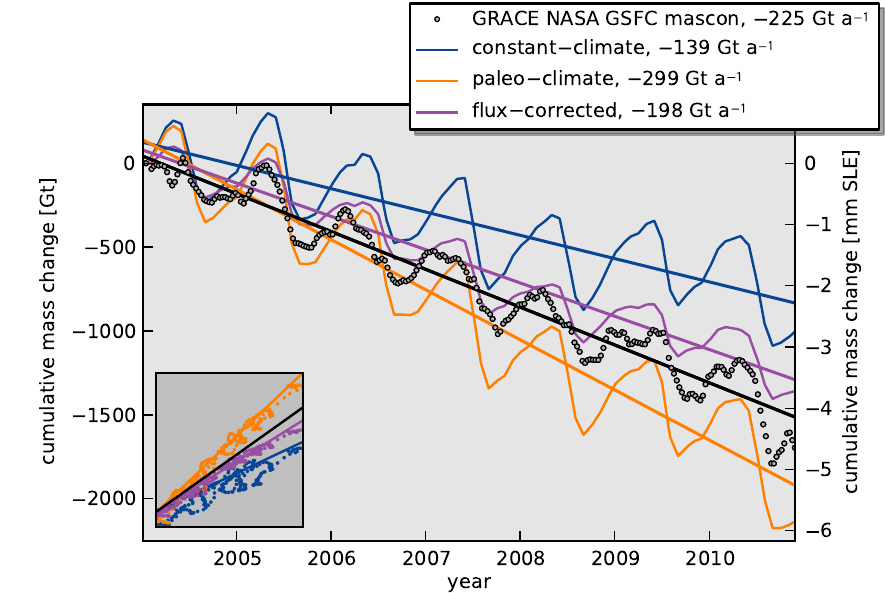
Fig. 4. Observed and modeled cumulative mass changes. 10-day solutions from GRACE observations (Luthcke et al., 2013) and simulated daily values starting from the three initial states. The inset figure shows the regression analysis; trends are given in the legend and correlation coefficients are listed in Table 1.